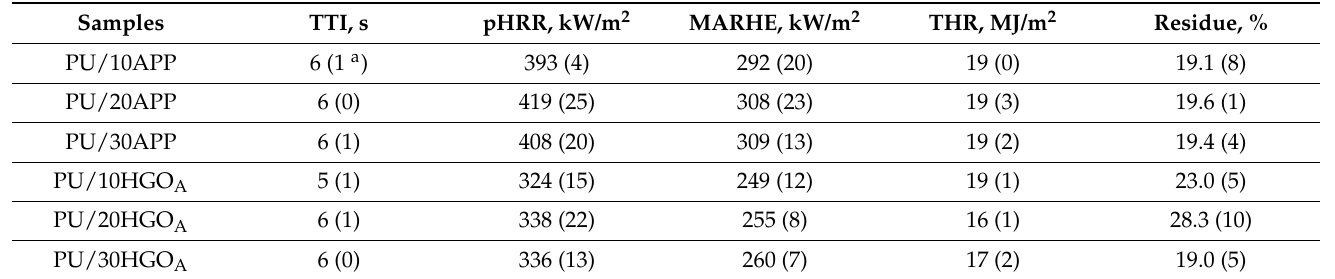
Figure 9. Representative curves of heat release rate of polyurethane foams with APP and HGO A system. Table 7. Cone calorimeter results of polyurethane foams with APP or HGO A system.